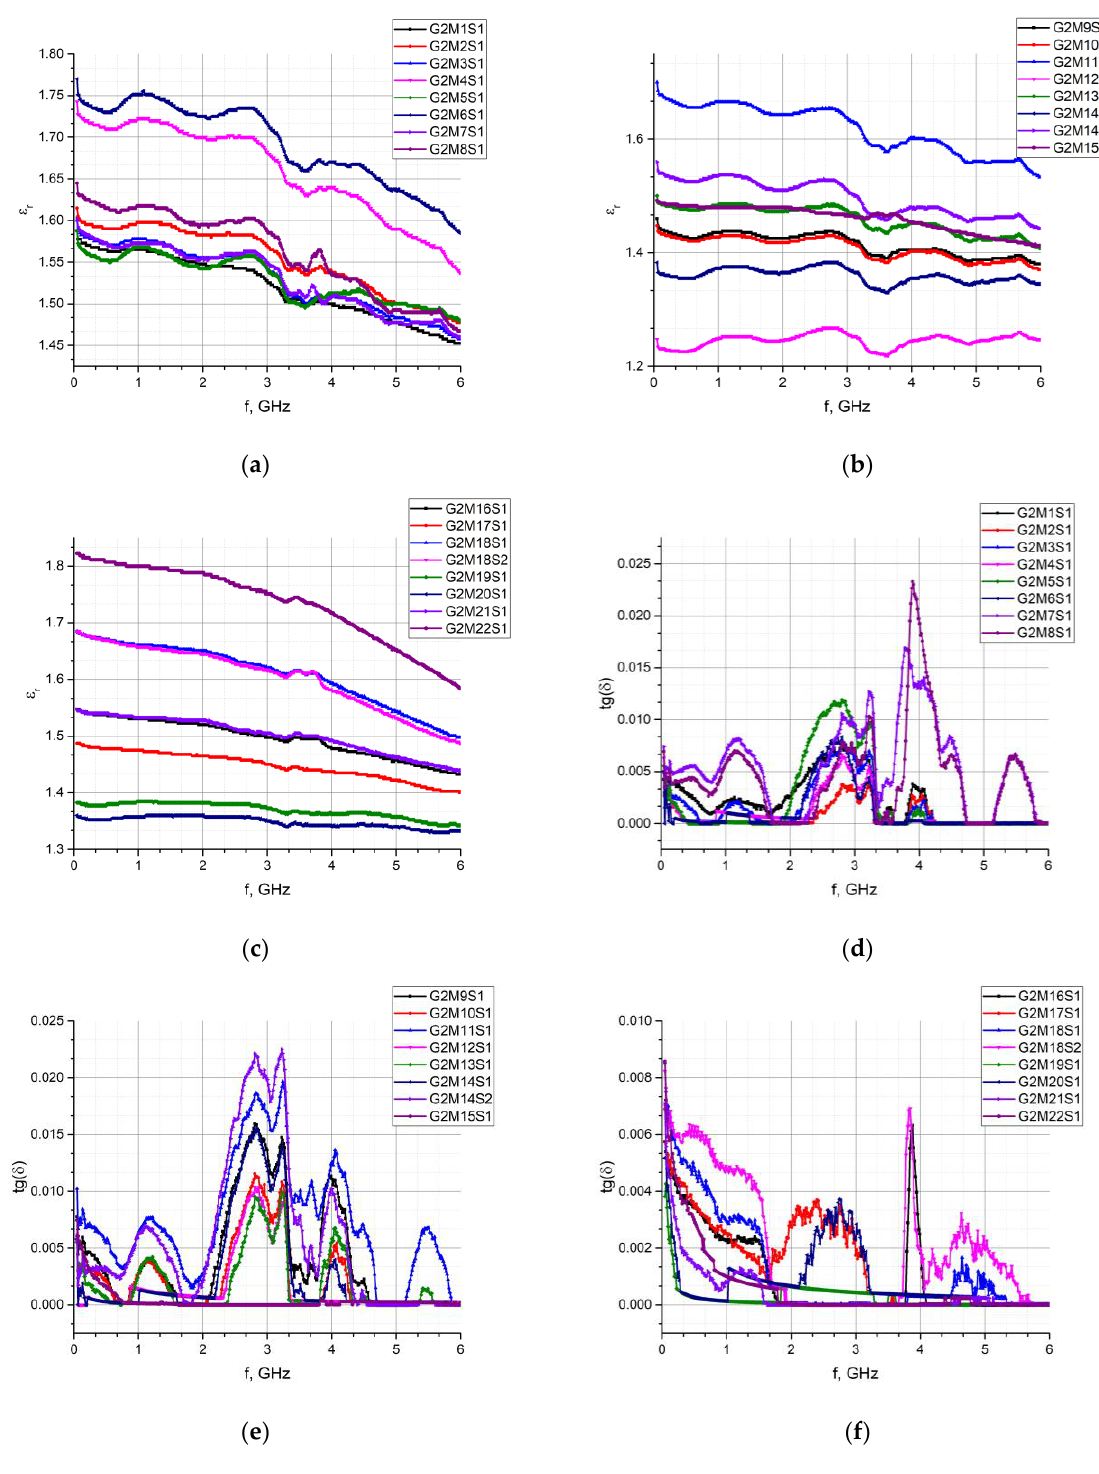
Figure 13. Comparison of dielectric parameters obtained in G2 group of fabrics: ( a ) ε r for G2M1S1 – G2M8S1; ( b ) ε r for G2M9S1 – G2M15S1; ( c ) ε r for G2M16S1 – G2M22S1; ( d ) tg δ for G2M1S1 – G2M8S1; G2M8S1; ( b ) ε r for G2M9S1–G2M15S1; ( c ) ε r for G2M16S1–G2M22S1; ( d ) tg δ for G2M1S1–G2M8S1; ( e ) tg δ for G2M9S1 – G2M15S1; ( f ) tg δ for G2M16S1 – G2M22S1. ( e ) tg δ for G2M9S1–G2M15S1; ( f ) tg δ for